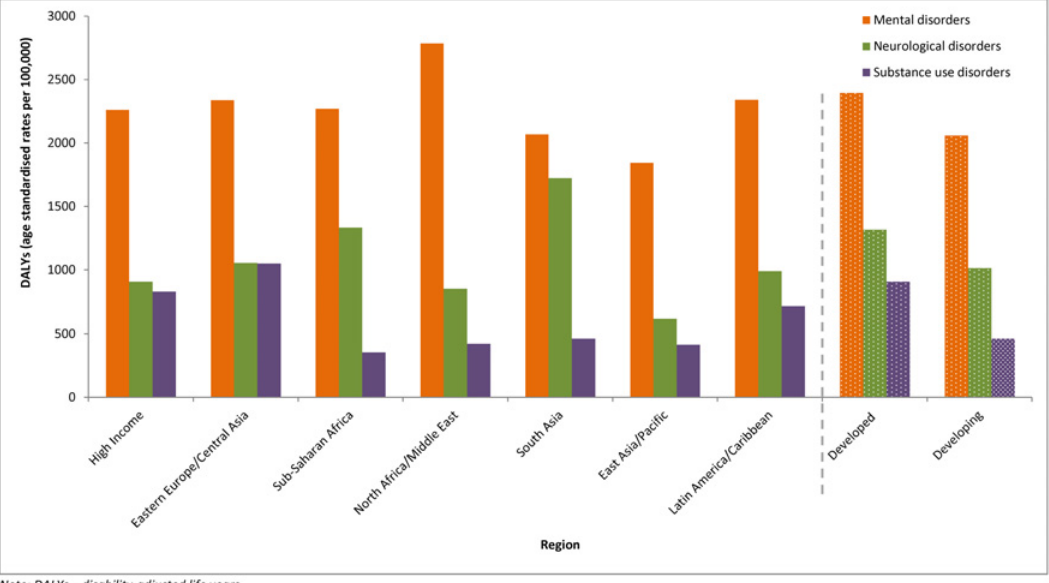
Fig 3. Age-Standardized DALY Rates Attributable to Mental, Neurological, and Substance Use Disorders, by Region, 2010.